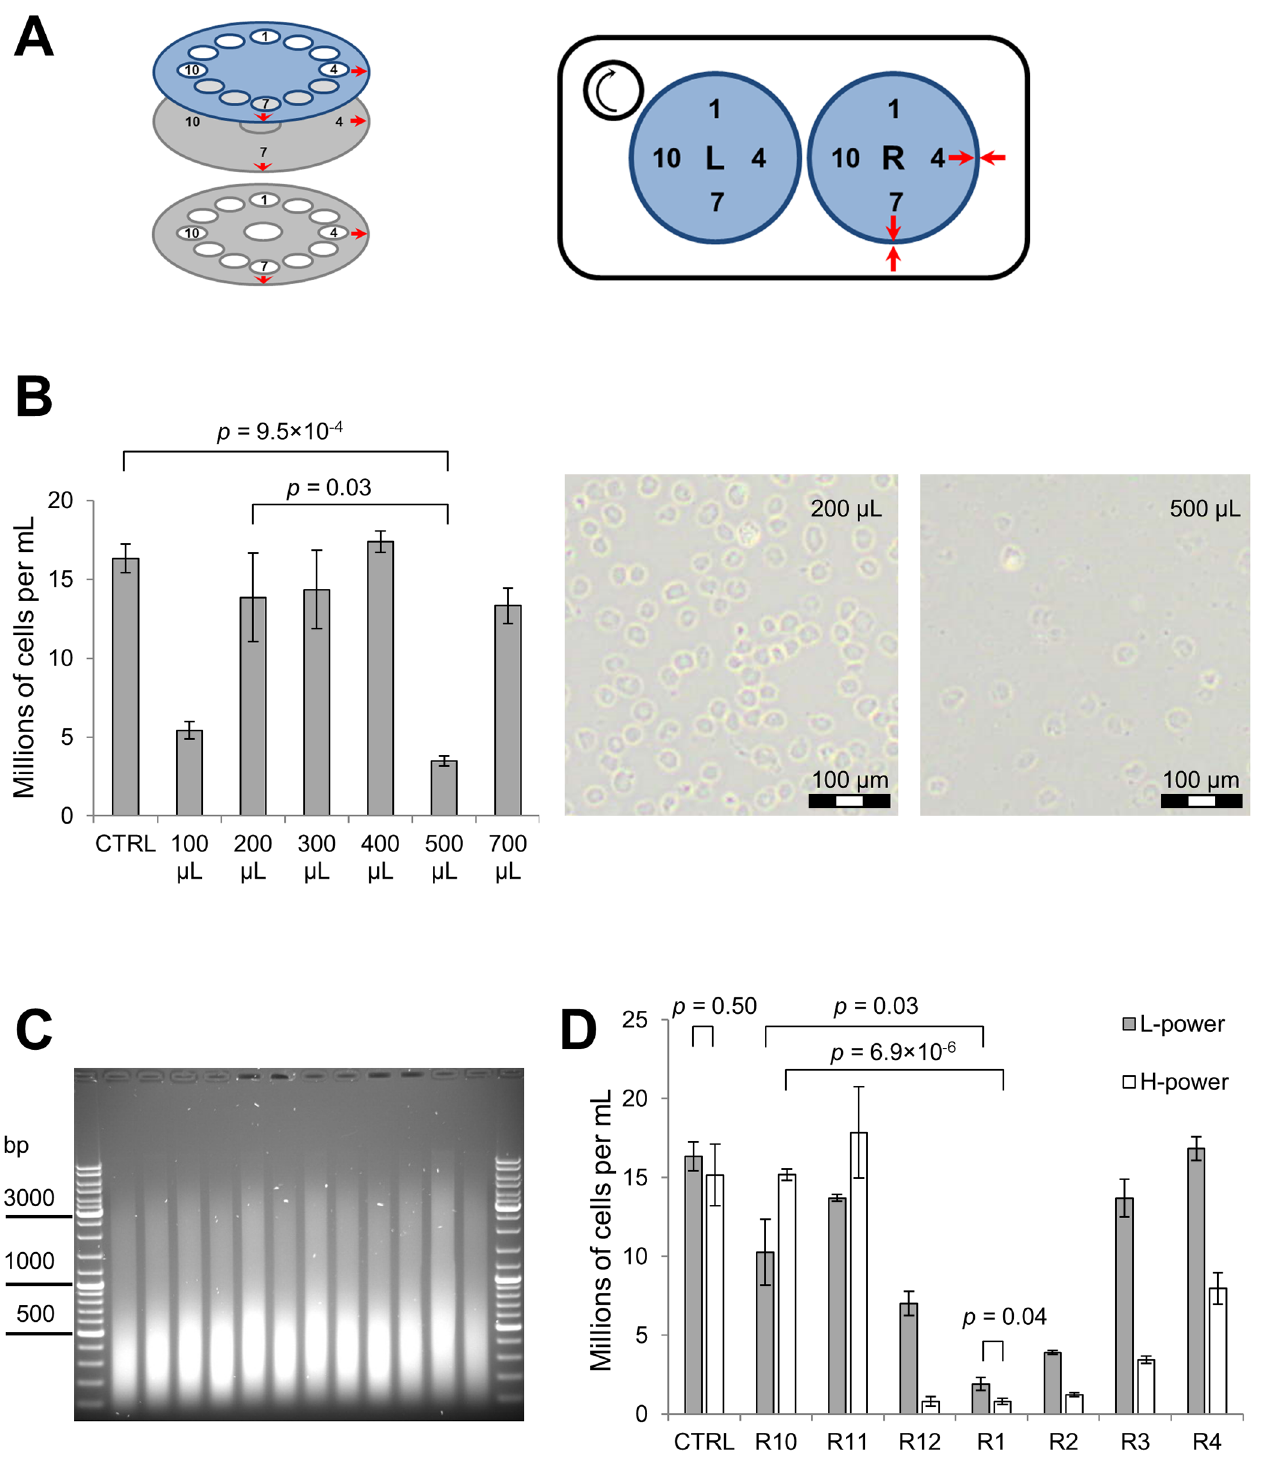
Fig 1. Systematic optimization of sonication conditions. Part 1. (A) Schematic of the Bioruptor XL water bath with tube positions numbered from 1 to 12 in the left (L) and right (R) carousels; red arrows indicate the alignment marks for carousel assembly and positioning. (B) The effect of sample volume on sonication efficiency at low power setting. Cell suspensions of variable volume (100 – 700 μ L, as indicated) were loaded into positions L3, L4, L5, L9, L10 and L11. Vacant L-positions were filled with tubes containing 500 μ L of water. Sonication was carried out for 8 min in 1:4 ELB:H 2 O (0.1% SDS final concentration), 24 sec ON/24 sec OFF pulses, with rotation and no floating ice. Remaining intact cells were counted three times and the respective means